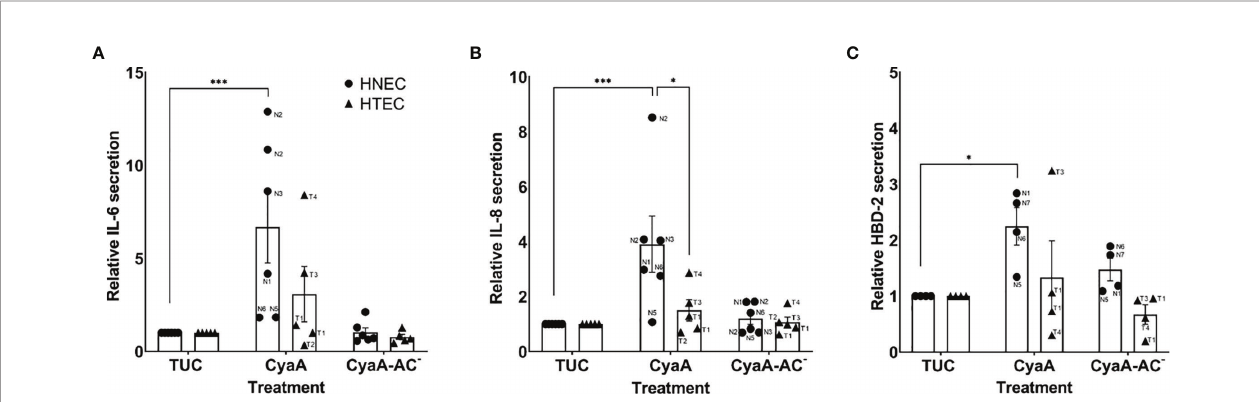
FIGURE 4 | Relative IL-6, IL-8 and HBD-2 secretion of human airway mucosa tissue models after CyaA treatment. CyaA signi fi cantly altered relative IL-6 (A) , IL-8 (B) and HBD-2 secretion (C) in nasal tissue models (HNEC), whereas tracheo-bronchial tissue models (HTEC) were not signi fi cantly affected. Data are presented as means ± SEM of independent experiments performed in duplicates. (A, B) N=6 for HNEC, N=5 for HTEC; (C) N=4 for HNEC and HTEC). ***p value of Dunnett ’ s multiple comparison test (TUC vs. CyaA) ≤ 0.001, *p value of Dunnett ’ s multiple comparison test (TUC vs. CyaA) ≤ 0.05, *p value of Tukey ’ s multiple comparison test (HNEC vs. HTEC) ≤ 0.05. The graphs also show individual data points of independent experiments to analyze inter- and intra-donor variance. When no obvious inter- or intra-donor variance was observed, individual data points were not